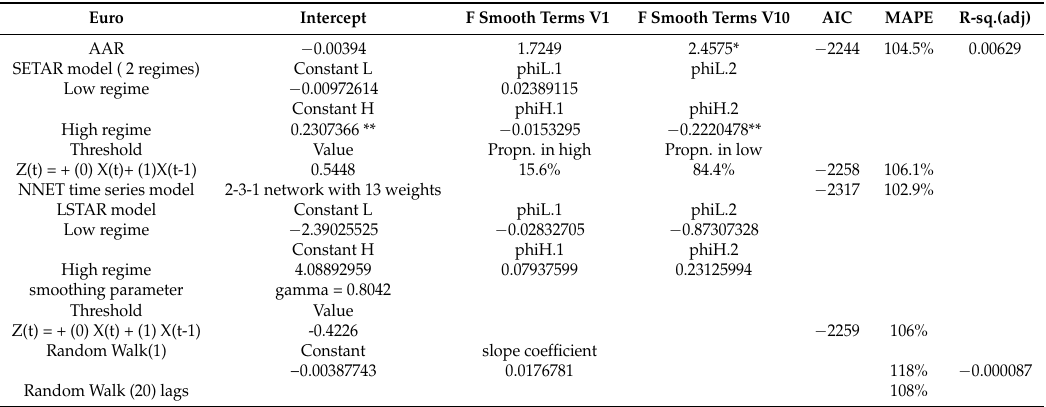
Table 4. Non-linear